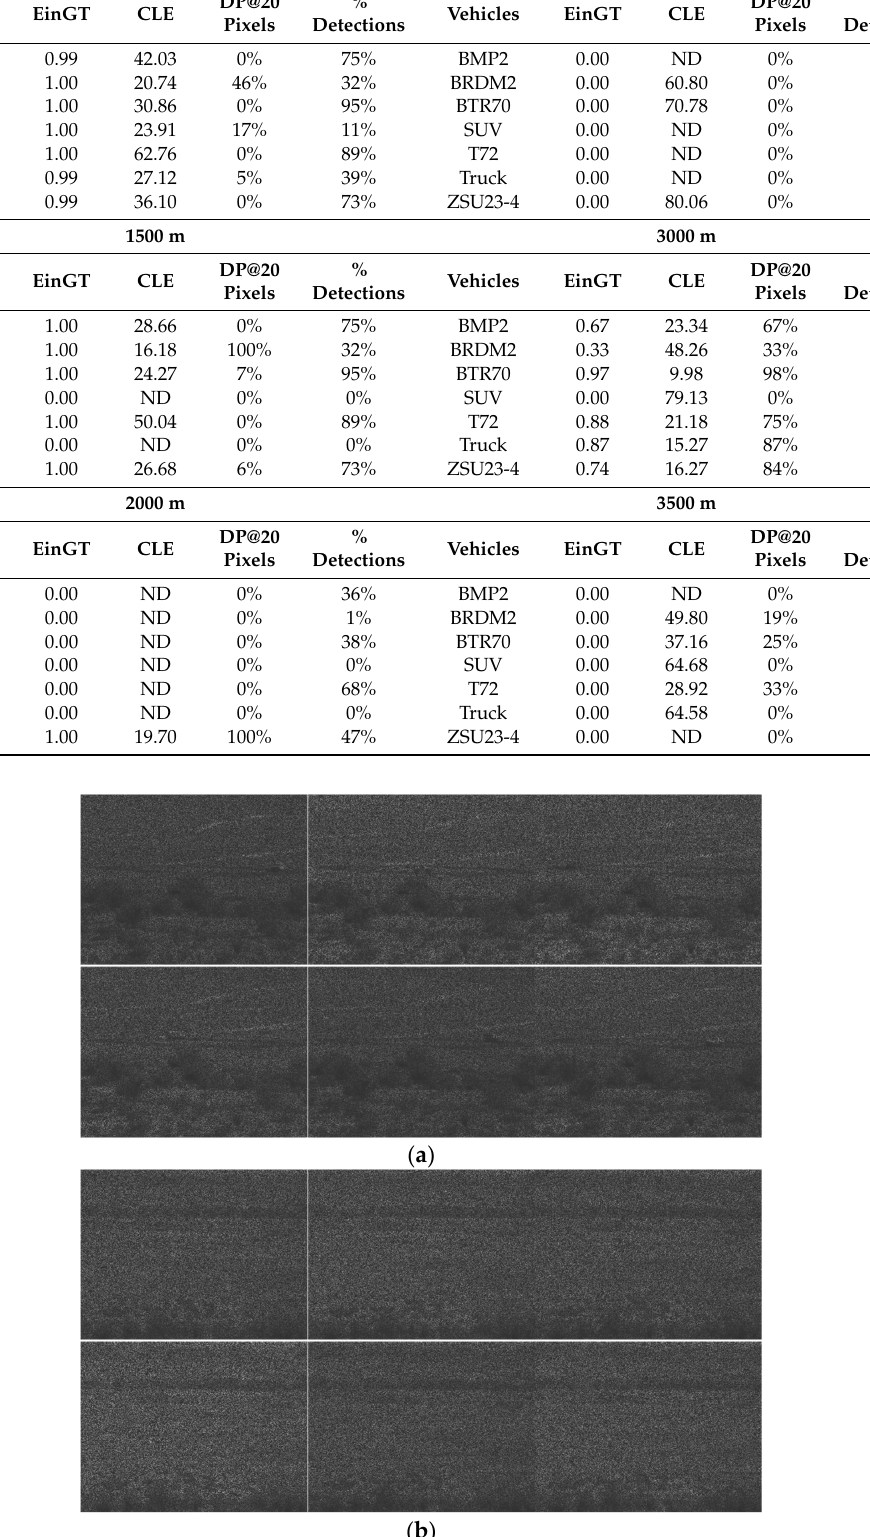
Table A2. Tracking metrics for PCE 25 (optical video). ND means “no detection”. 1000 m 2500 m